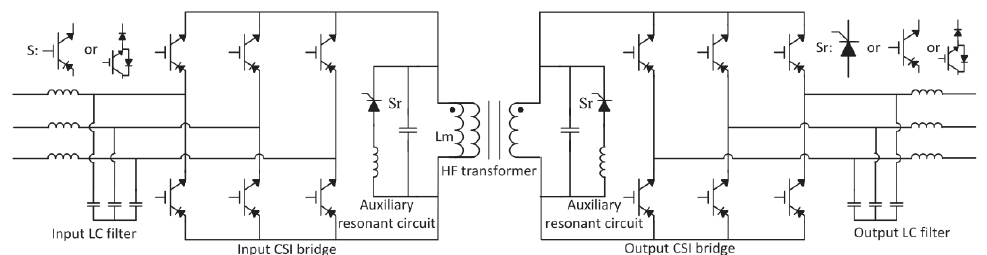
Figure 7. Soft-switching SST in AC/AC three-phase configuration